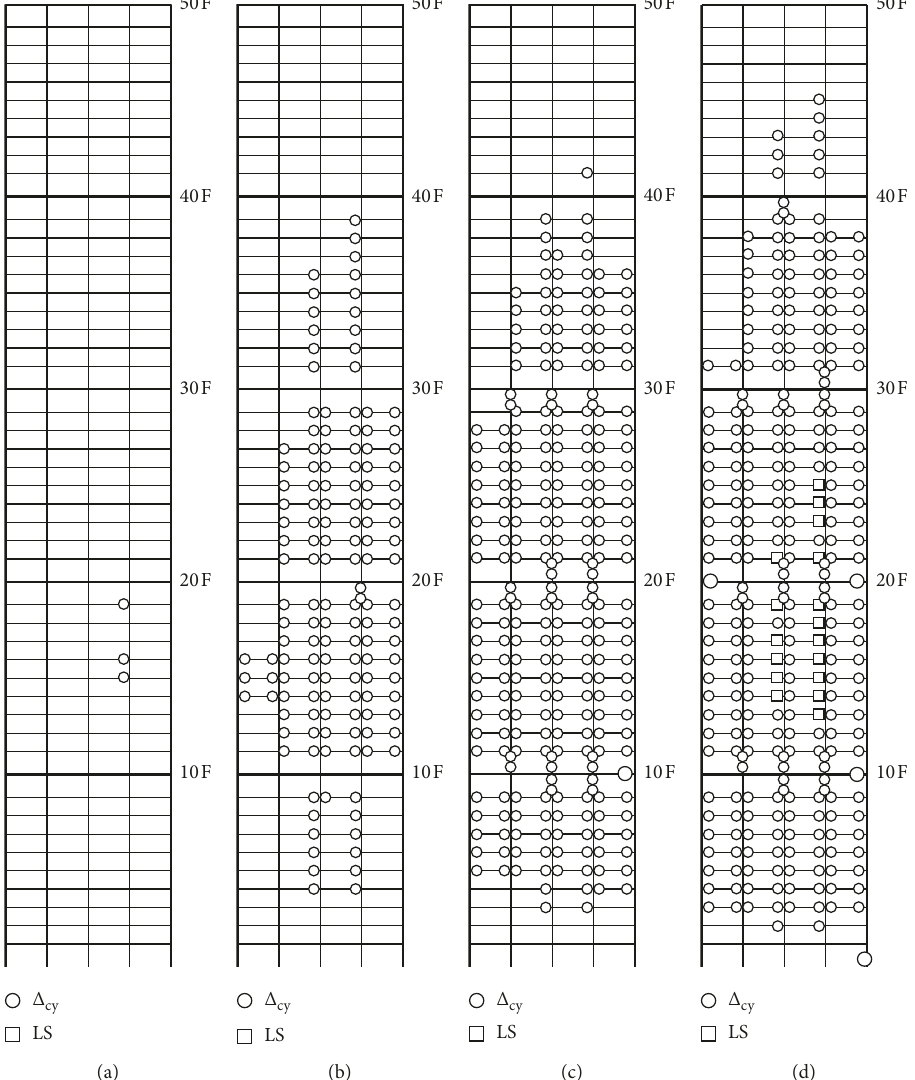
Figure 11: Plastic hinge formation in the web-side frame of model 5MC: (a) first yield ( δ (c) primary beam yield ( δ